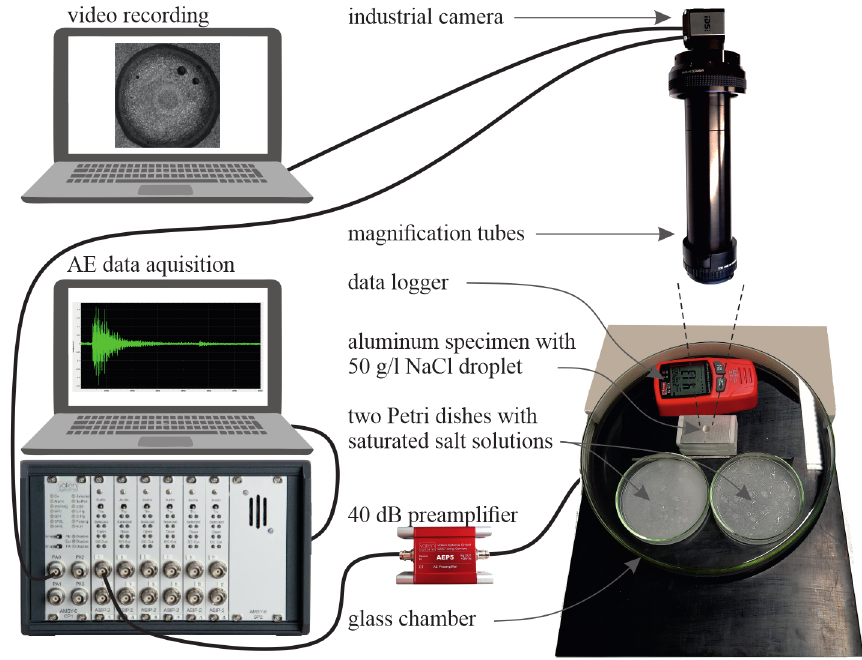
Figure 3. Experimental setup of the atmospheric corrosion experiment. AE monitoring of atmospheric corrosion during a controlled variation of the RH and additional visual observation of the corrosion by an industrial